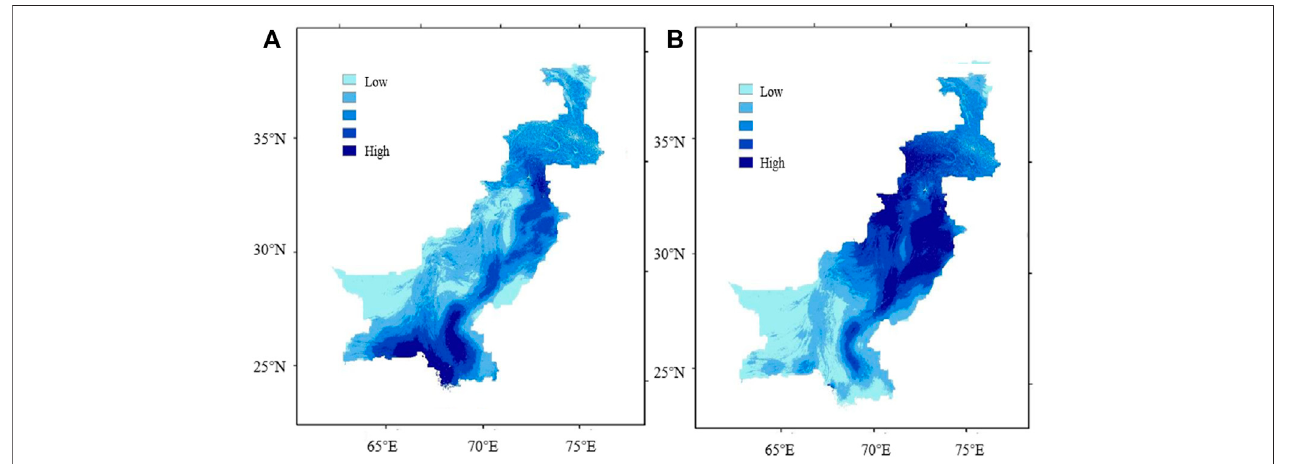
FIGURE 9 | Flood risk zoning in different return periods under future scenarios (SSP5-8.5). (A) 20-year fl ood risk zoning. (B) 100-year fl ood risk